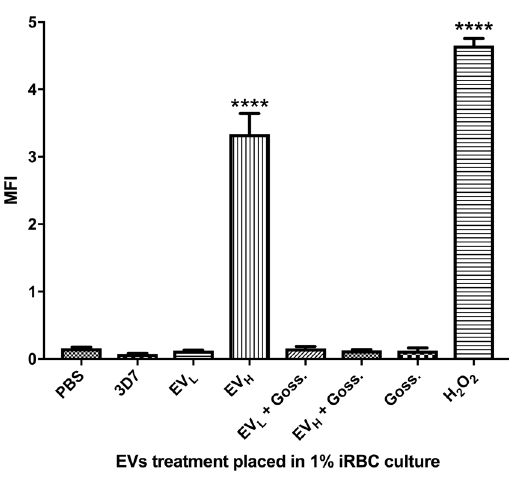
Figure 4. ROS detection after addition of EVs and 0.25 µ M gossypol. MFI was measured by flow cytometry after diverse EV and gossypol treatment. The average and S.D. of 3 replicas for each treatment is shown. (mean ± s.e.m.; n = 3 replicas), **** P < 0.0001 versus PBS control (Bonferroni’s